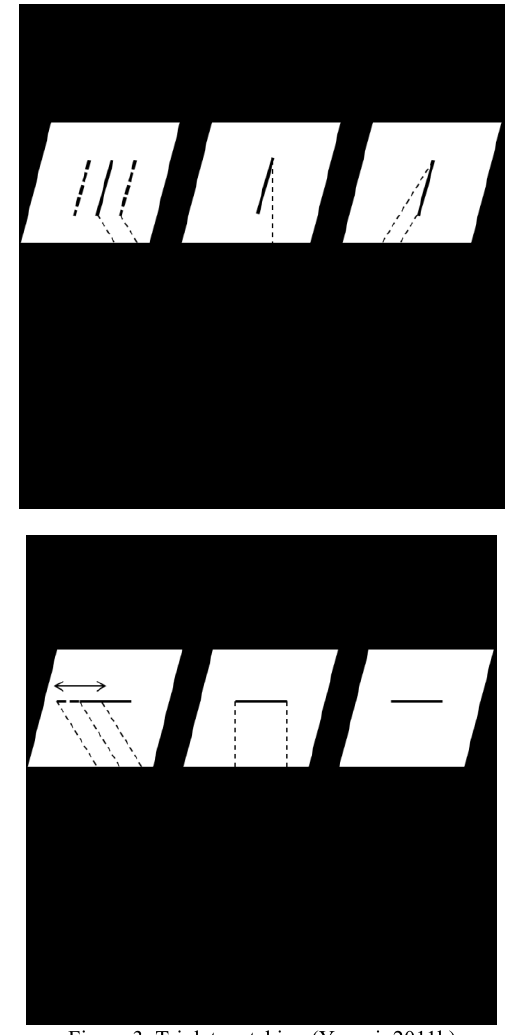
Figure 3. Triplet matching (Yanagi, 2011h) 2.2 Line segment matching Two parameters are used in line segment matching, as shown in Figure 4. The first parameter is a length of line segment. Each Figure 2. Input image (top image) corresponded paralleled line segment to the flight direction changes its length in triplet images considerably. On the other hand, each corresponded orthogonalize line segment to the flight direction has almost same length in triplet images, as shown in Figure 5. Although edges should be successfully extracted from nadir, forward, and backward images, the length of line segment is one of useful parameters in line matching.